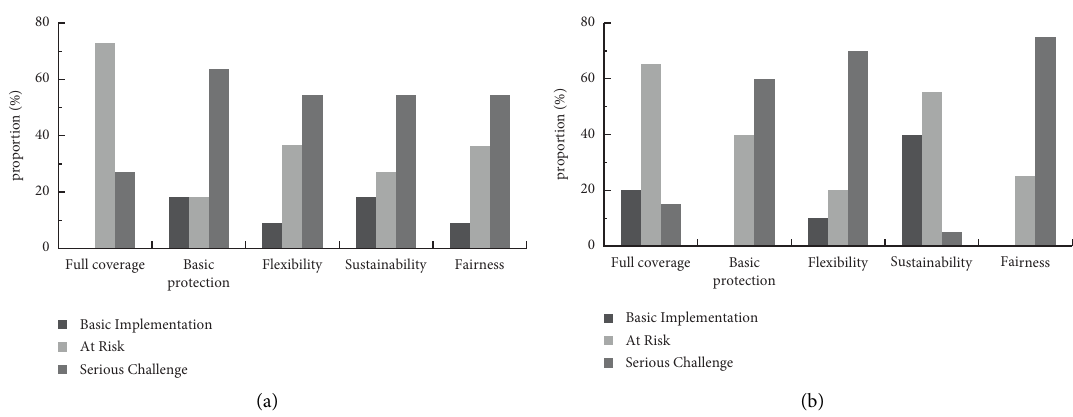
Figure 3: The differences between the targets in the (a) eastern region and (b) the central and western rankings (Table 2), there are seven midwestern provinces in the top 10 in the country, and Hubei ranks first, with an absolute advantage of 0.752. Most provinces in the eastern region, such as Jiangsu, Guangdong, and Zhejiang, are ranked lower than those in the midwestern region, even appeared at the bottom of the rankings.